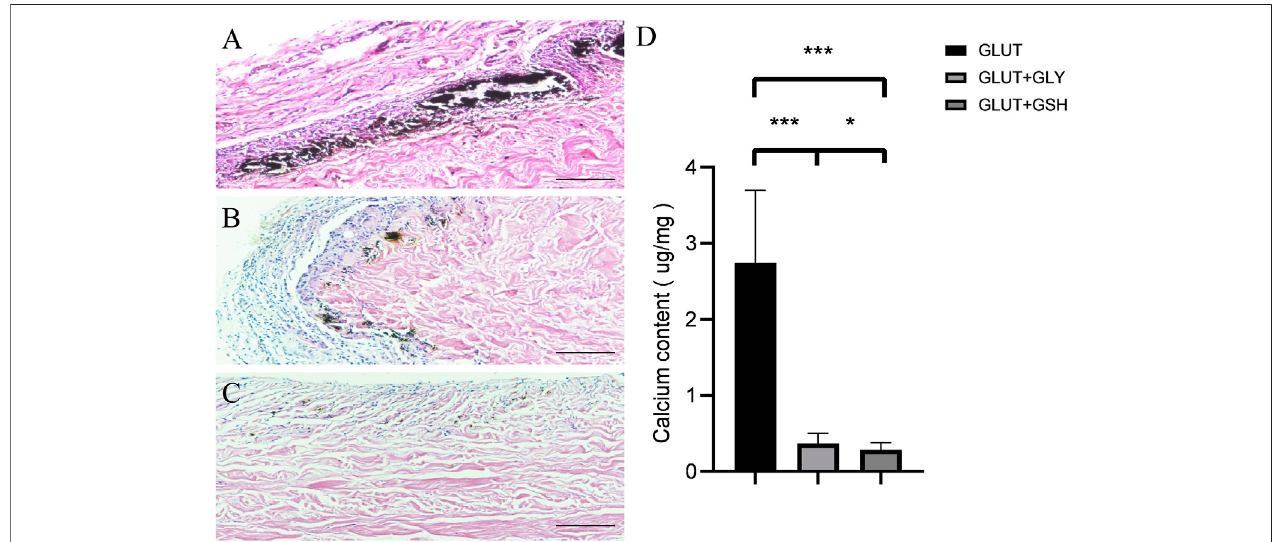
FIGURE 7 | After 8 weeks of subcutaneous implantation in the rat, the BPs were taken out for Von kossa calcium staining and calcium content determination. The (A – C) isthecalcium staining inthe GLUT group and the GLUT +GLY and GLUT + GSH treatmentgroups. The black scale bars are 500um. TheFig.7 (D) is thecalcium content determination in the GLUT group and the GLUT + GLY and GLUT + GSH ( n = 10; p p < 0.05; pp p < 0.01; ppp p < 0.001, pppp p <